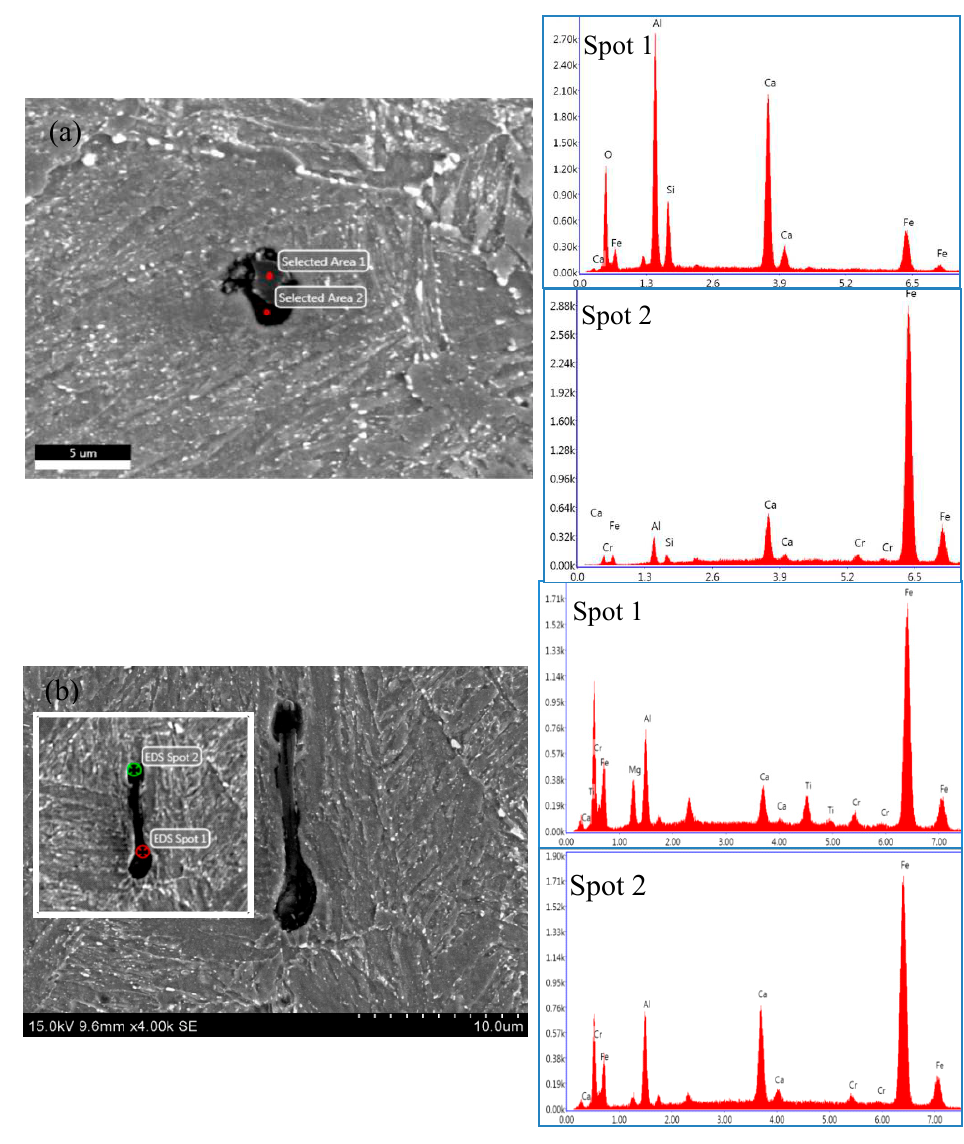
Figure 13. ( a ) Corrosion pit and ( b ) secondary microcrack typically initiating from massive Al 2 O 3 ∙ SiO ∙ CaO and slender Al 2 O 3 ∙ SiO ∙ CaO ∙ TiO complex inclusions, respectively, underneath the SSC fracture surface of DCB sample tempered at 700 ° C .